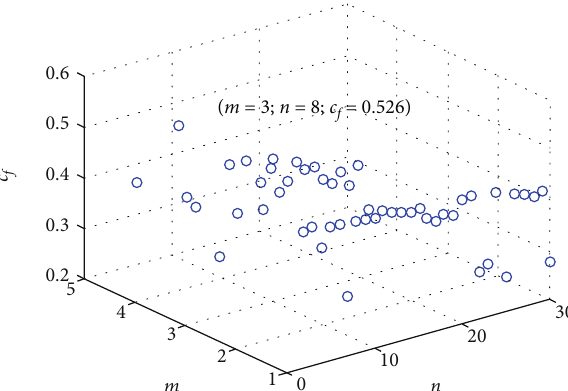
Figure 3: The results of c on the awake condition. n and m are the f node numbers of middle layer on fi rst autoencoder and second autoencoder,